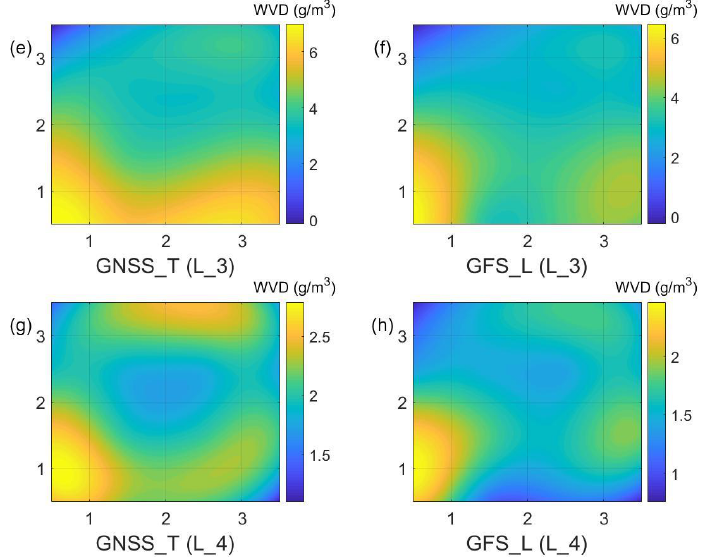
Figure 7. ( a ) GNSS_T of the first layer; ( b ) GFS_L of the first layer; ( c ) GNSS_T of the second layer; ( d ) GFS_L of the second layer; ( e ) GNSS_T of the third layer; ( f ) GFS_L of the third layer; ( g ) GNSS_T of the fourth layer; ( h ) GFS_L of the fourth layer. The isosurface map of the lower level shows that the two results are in good agree- ment, and the comparison result of the water vapor density profile at the same station also indicates the correlation between the two results. Figure 8 shows that the water vapor density profile of GNSS_T is more in line with the exponential change, which satisfies the previous vertical constraints. The deviations between the two results of the first layer to the fourth layer are small. The results of the GFS change significantly above layer 9, while the results of the GNSS tomography are stable. The tomography results above layer 5 are larger than those of GFS, and the absolute value of the deviation is within 1 g/m 3 .